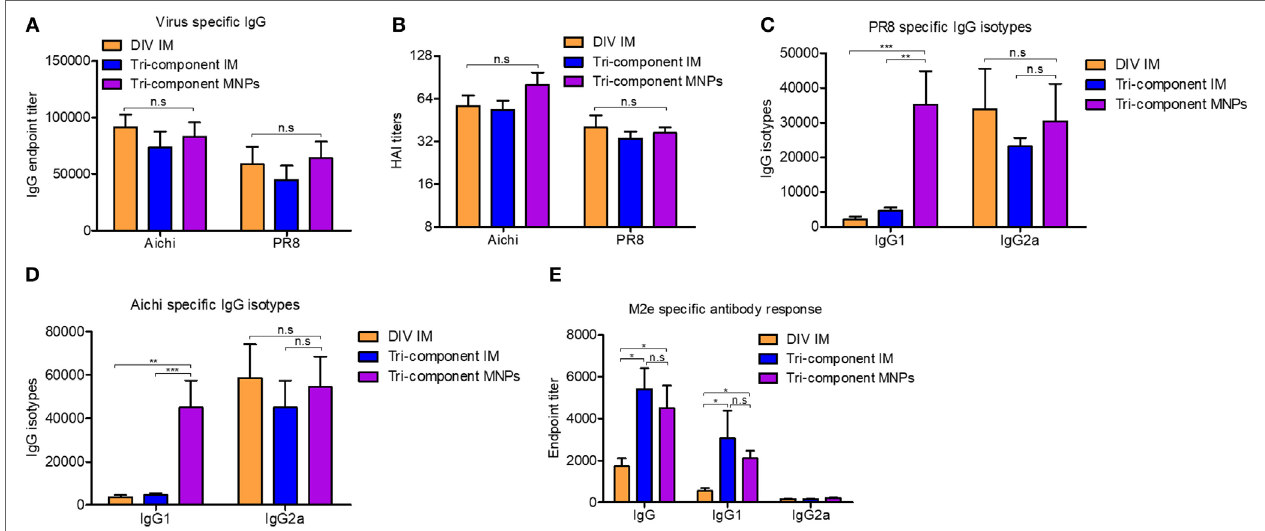
FigUre 1 | Evaluation of humoral immune response. BALB/c mice were intramuscular (IM) immunized with Aichi and PR8-inactivated bi-component vaccine [divalent inactivated vaccine (DIV)], the combination of the 4M2e-tFliC fusion protein, Aichi and PR8-inactivated tri-component vaccine, or microneedle patch (MNP) skin vaccination with the tri-component vaccine. Serum samples ( N = 8) were collected 3 weeks post immunization and analyzed for levels of Aichi-specific IgG (a) and IgG isotypes (D) , PR8-specific IgG (a) and IgG isotypes (c) and M2e-specific IgG and IgG isotypes (e) . (B) Hemagglutinin inhibition titers against Aichi and PR8. Data represent mean ± SEM. The statistical significance was analyzed by Mann–Whitney U test. * p < 0.05, ** p < 0.01, *** p < 0.001, n.s p >